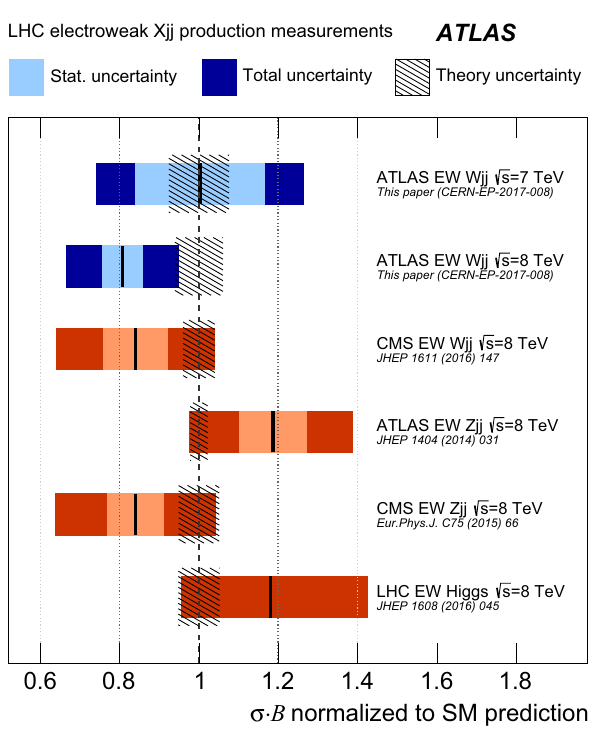
Fig. 10 Measurements of the cross section times branching fractions of electroweak production of a single W , Z , or Higgs boson at high dijet invariant mass, divided by the SM predictions ( Powheg + Pythia8 for ATLAS, Madgraph + Pythia8 for CMS, and Powheg + Pythia8 for the LHC combination). The lighter shaded band (where shown) rep- resents the statistical uncertainty of the measurement, the outer darker band represents the total measurement uncertainty. Theoretical uncer- tainties in the SM prediction are represented by the shaded region cen- tred at unity